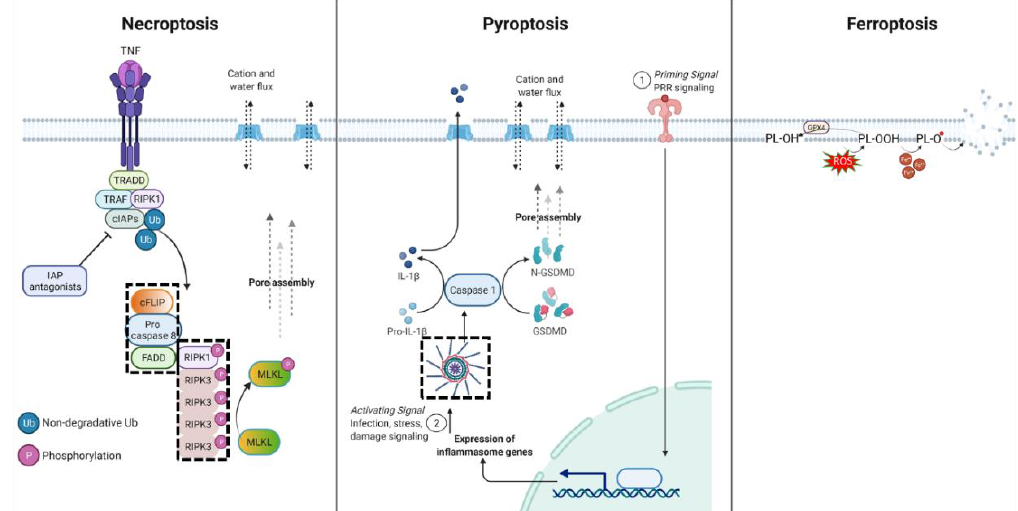
Figure 1. Immunogenic pathways. Dashed box denotes Supramolecular Organizing Centers (see Box 1). Abbreviations: TNF: tumor necrosis factor; TRADD: TNF receptor-associated death domain protein; TRAF: TNF receptor-associated factor; FADD: Fas-associated death domain protein; RIPK1/3: receptor interacting serine threonine kinase 1/3; cFLIP: cellular FLICE-like inhibitory pro- tein; IAP: inhibitor of apoptosis protein family; GSDMD: Gasdermin D; PRR: pattern recognition receptor; PL: phospholipid; GPX4: glutathione peroxidase 4. Created with BioRender.com, accessed on 21 April 2022.